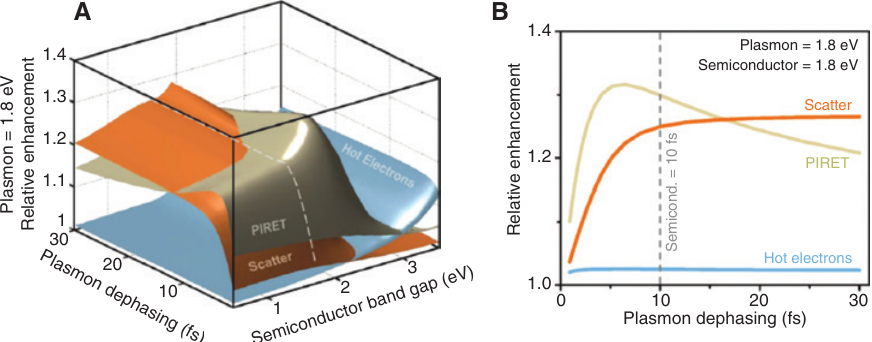
Figure 3: Comparison between far-field (scatter), near-field (PIRET), and hot electron-based plasmon energy conversion processes through theoretical estimates of the relative enhancement in semiconductor excitations. (A) Relative enhancement versus the plasmon’s dephasing stage and the semiconductor bandgap with the plasmon energy fixed at 1.8 eV. (B) Cut-out of the 3D plot in (A) at a semiconductor bandgap of 1.8 eV. The semiconductor dephasing time is shown for comparison. The dashed line in (A) shows the approximate position of the cut in (B). Adapted from Ref. [47] with permission from the PCCP Owner